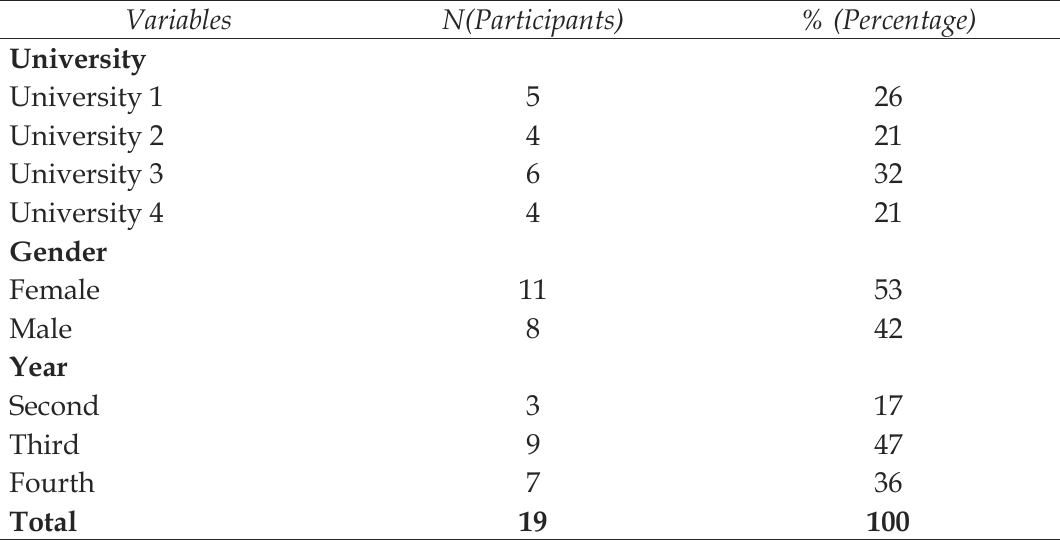
Distribution of students by independent variables Variables